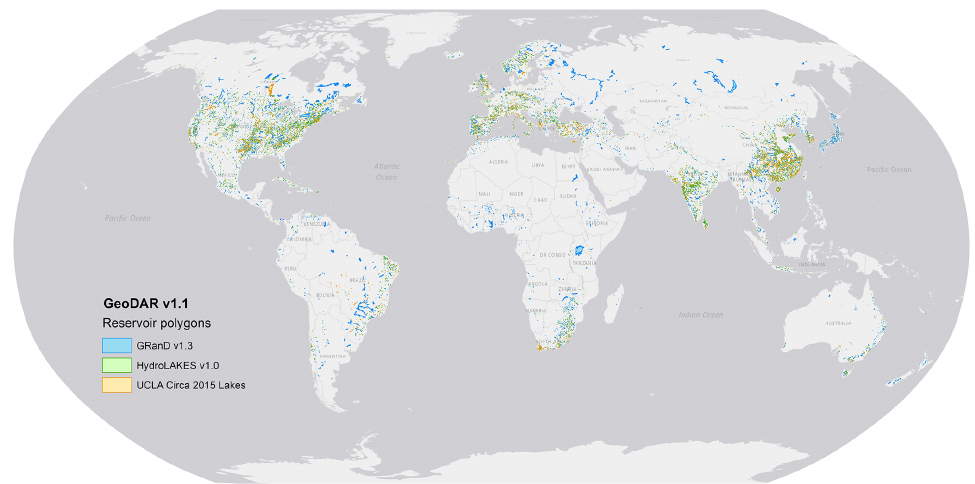
Figure 7. Reservoir polygons and their retrieval data sources in GeoDAR v1.1. For display, GRanD polygons are superimposed by Hydro- LAKES polygons and then by the UCLA Circa 2015 Lake